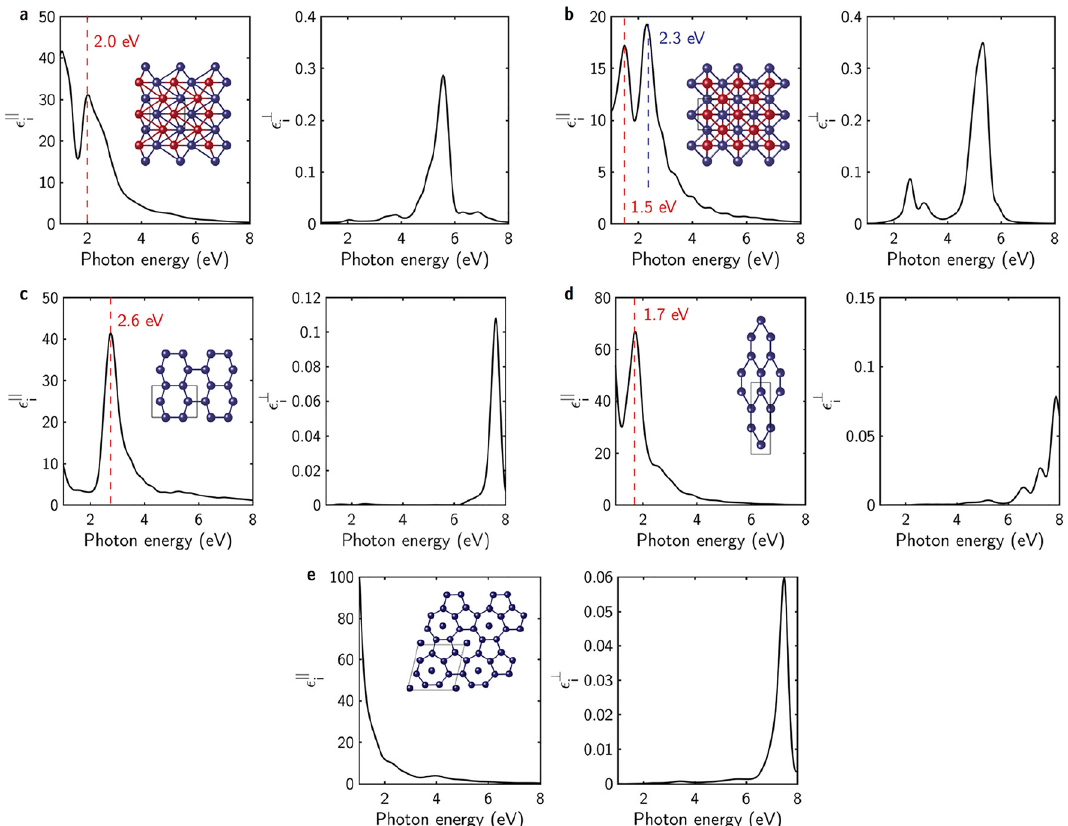
Figure11: Imaginarypartofin-plane( ϵ i ∥ ) andout-of-plane ( ϵ i ⊥ ) dielectricfunctionof thedifferentgallenenephases:(aandb) PBEandPBEsol bilayer gallenene, (c) compressed hexagonal gallenene, (d) elongated hexagonal gallenene, and (e) γ